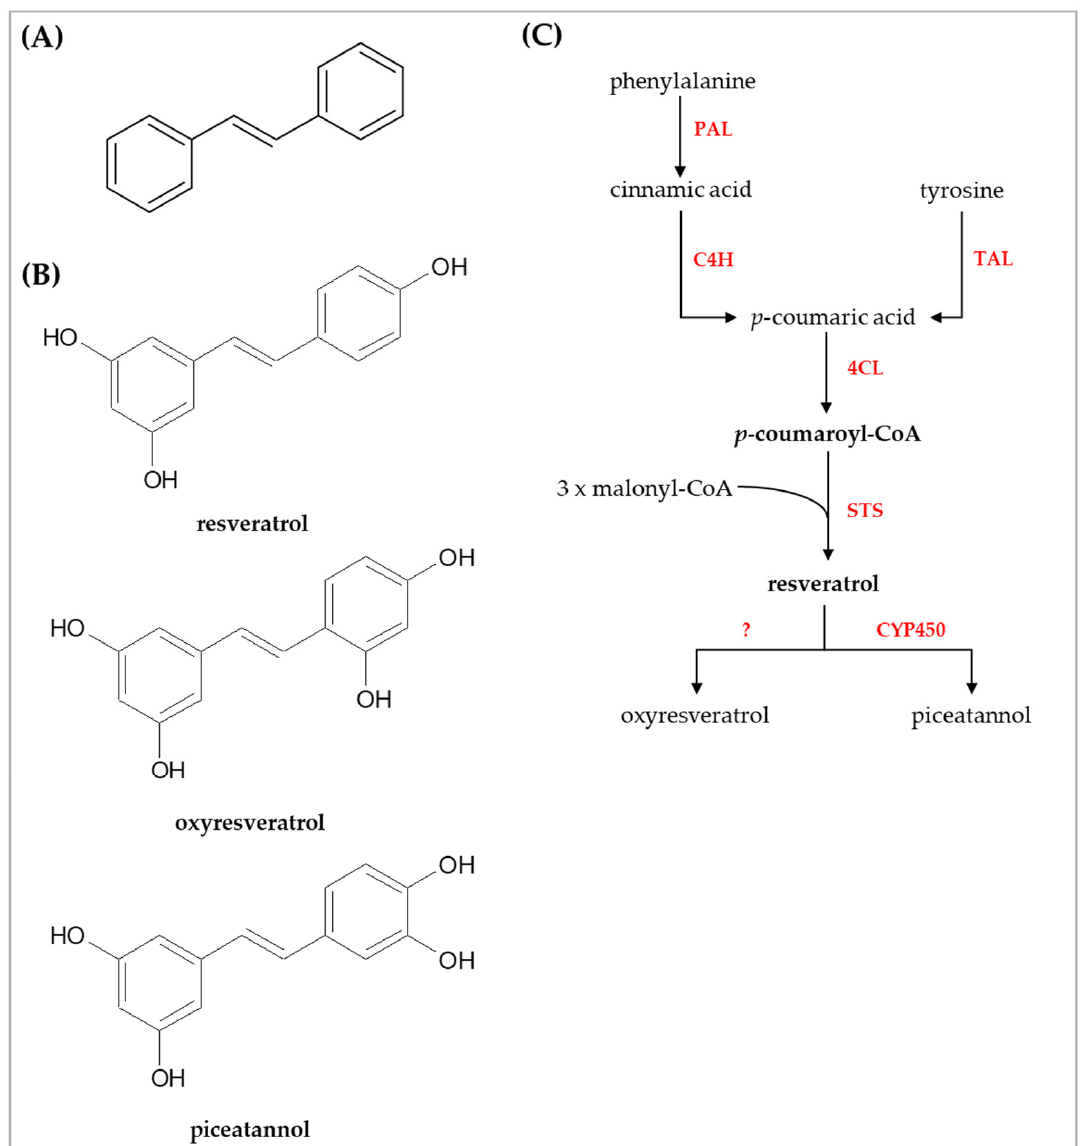
Figure 1. Chemical structures and biosynthesis of stilbenoids. ( A ) core structure of stilbenoids ( B ) chemical structures of resveratrol, oxyresveratrol, and piceatannol ( C ) overview of the biosynthetic pathway of stilbenoids. Abbreviations used: PAL, phenylalanine ammonia lyase; TAL, tyrosine am- monia lyase; C4H, cinnamate-4-hydroxylase; 4CL, 4-coumarate-CoA ligase; STS, stilbene synthase or resveratrol synthase; CYP450, cytochrome P450.